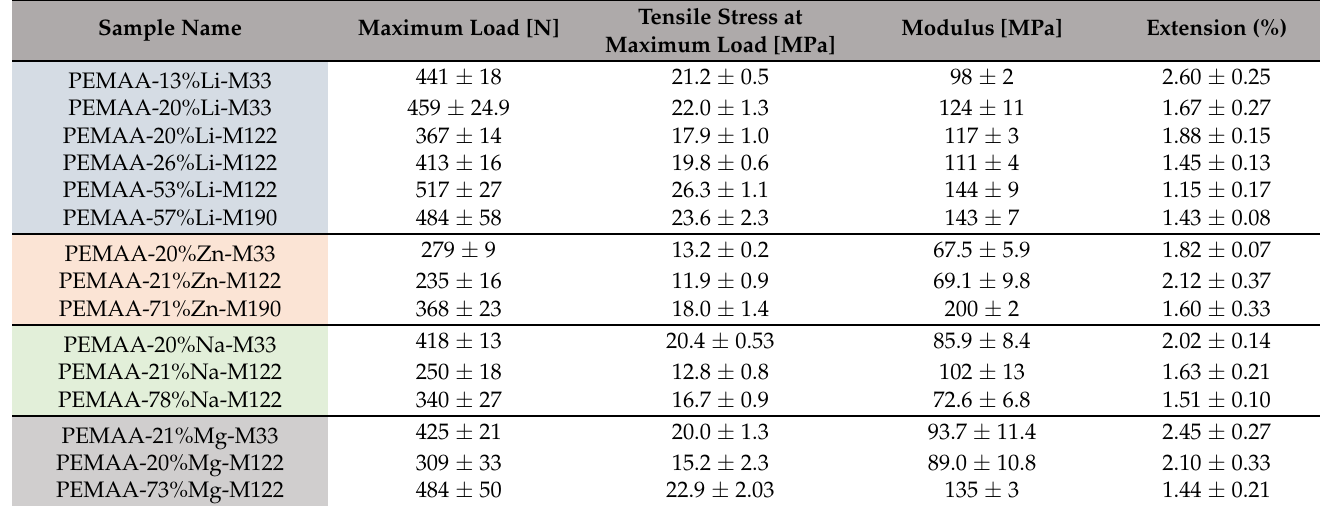
Table 3. Tensile testing results for the 15 PEMAA